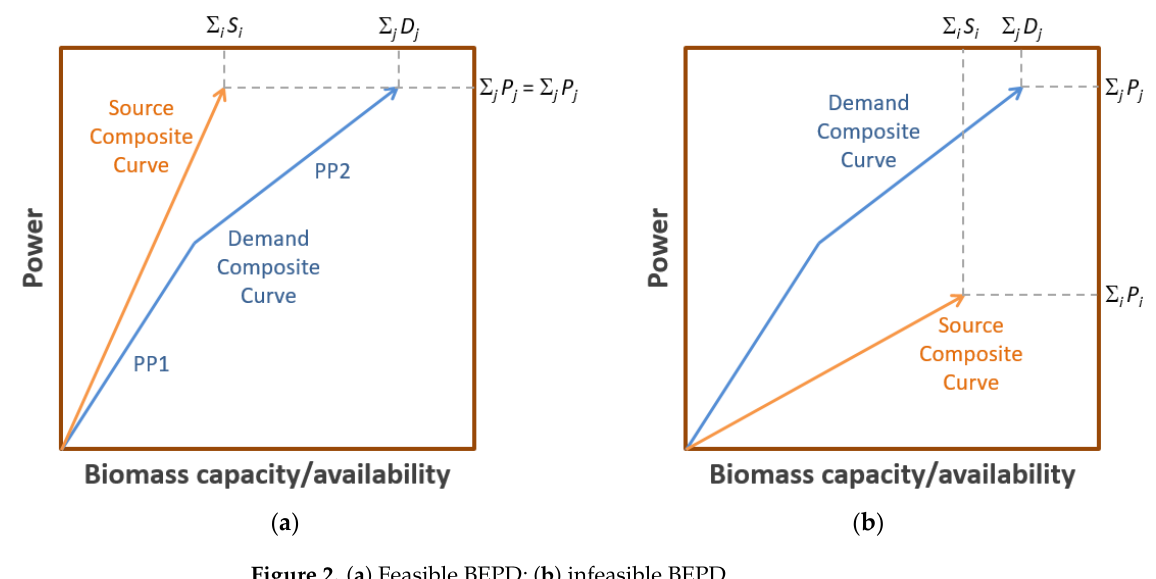
Figure 2. ( a ) Feasible BEPD; ( b ) infeasible